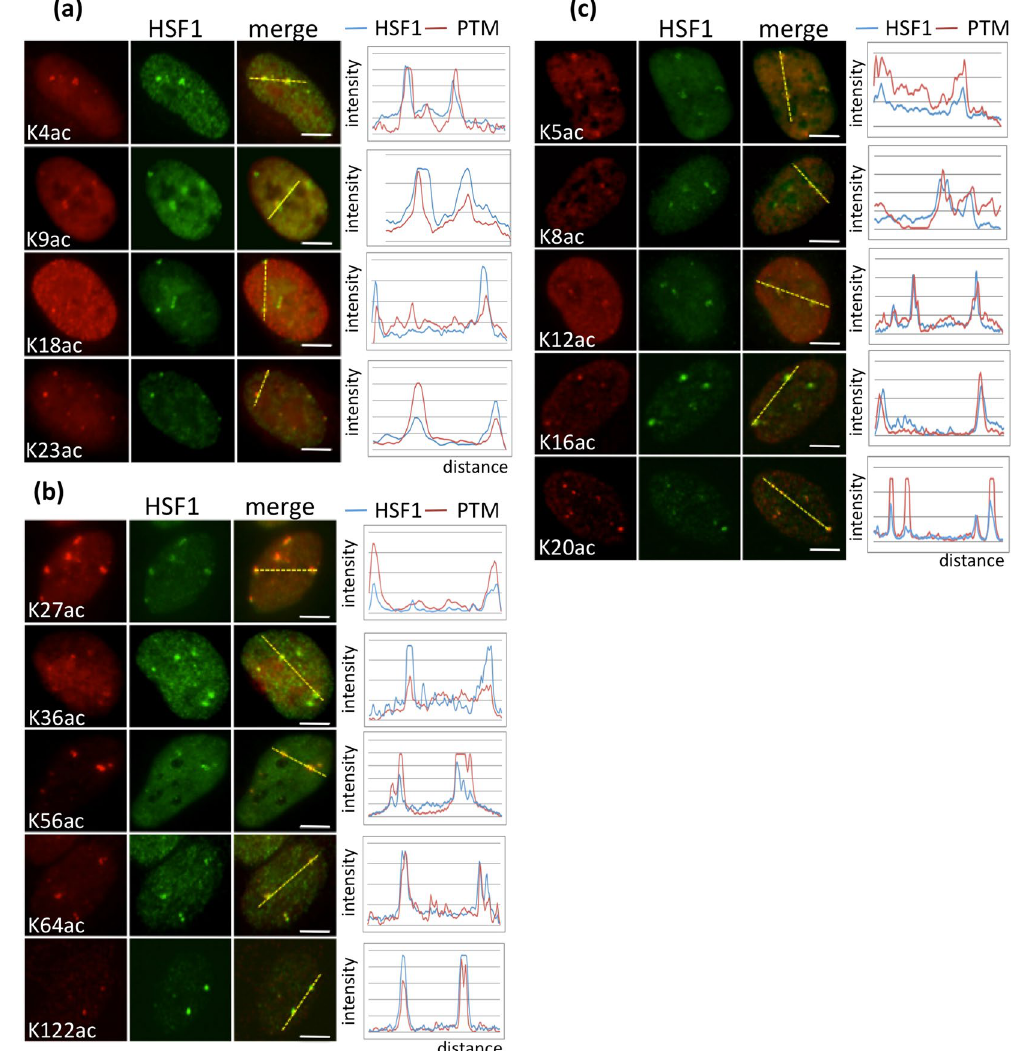
Figure 1. Status of active histones H3 and H4 marks at the 9q12 locus in HeLa stressed cells. ( a , b ) Active H3 and ( c ) H4 histone marks (red signals) and HSF1 (green signals) detected by immunofluorescence with fluorescence profiles (Scale bar = 5 µ m). PTM = Post Translational